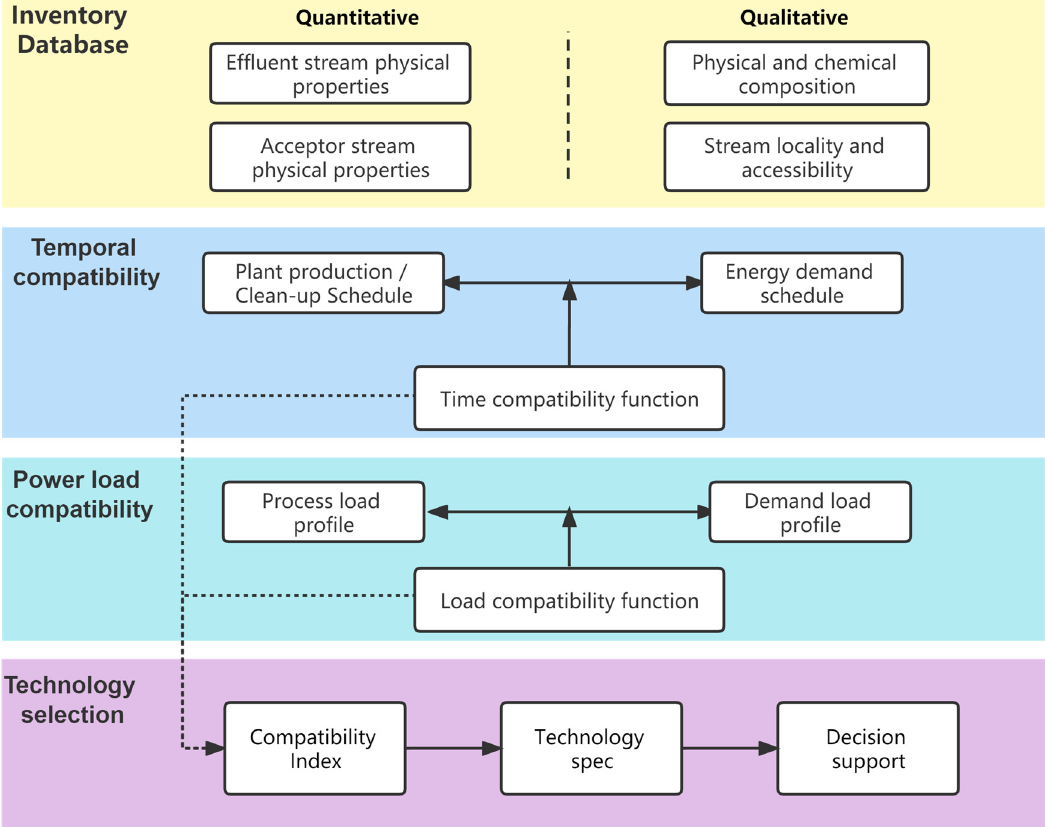
Figure 3. Decision support framework for food processing effluent heat recovery.